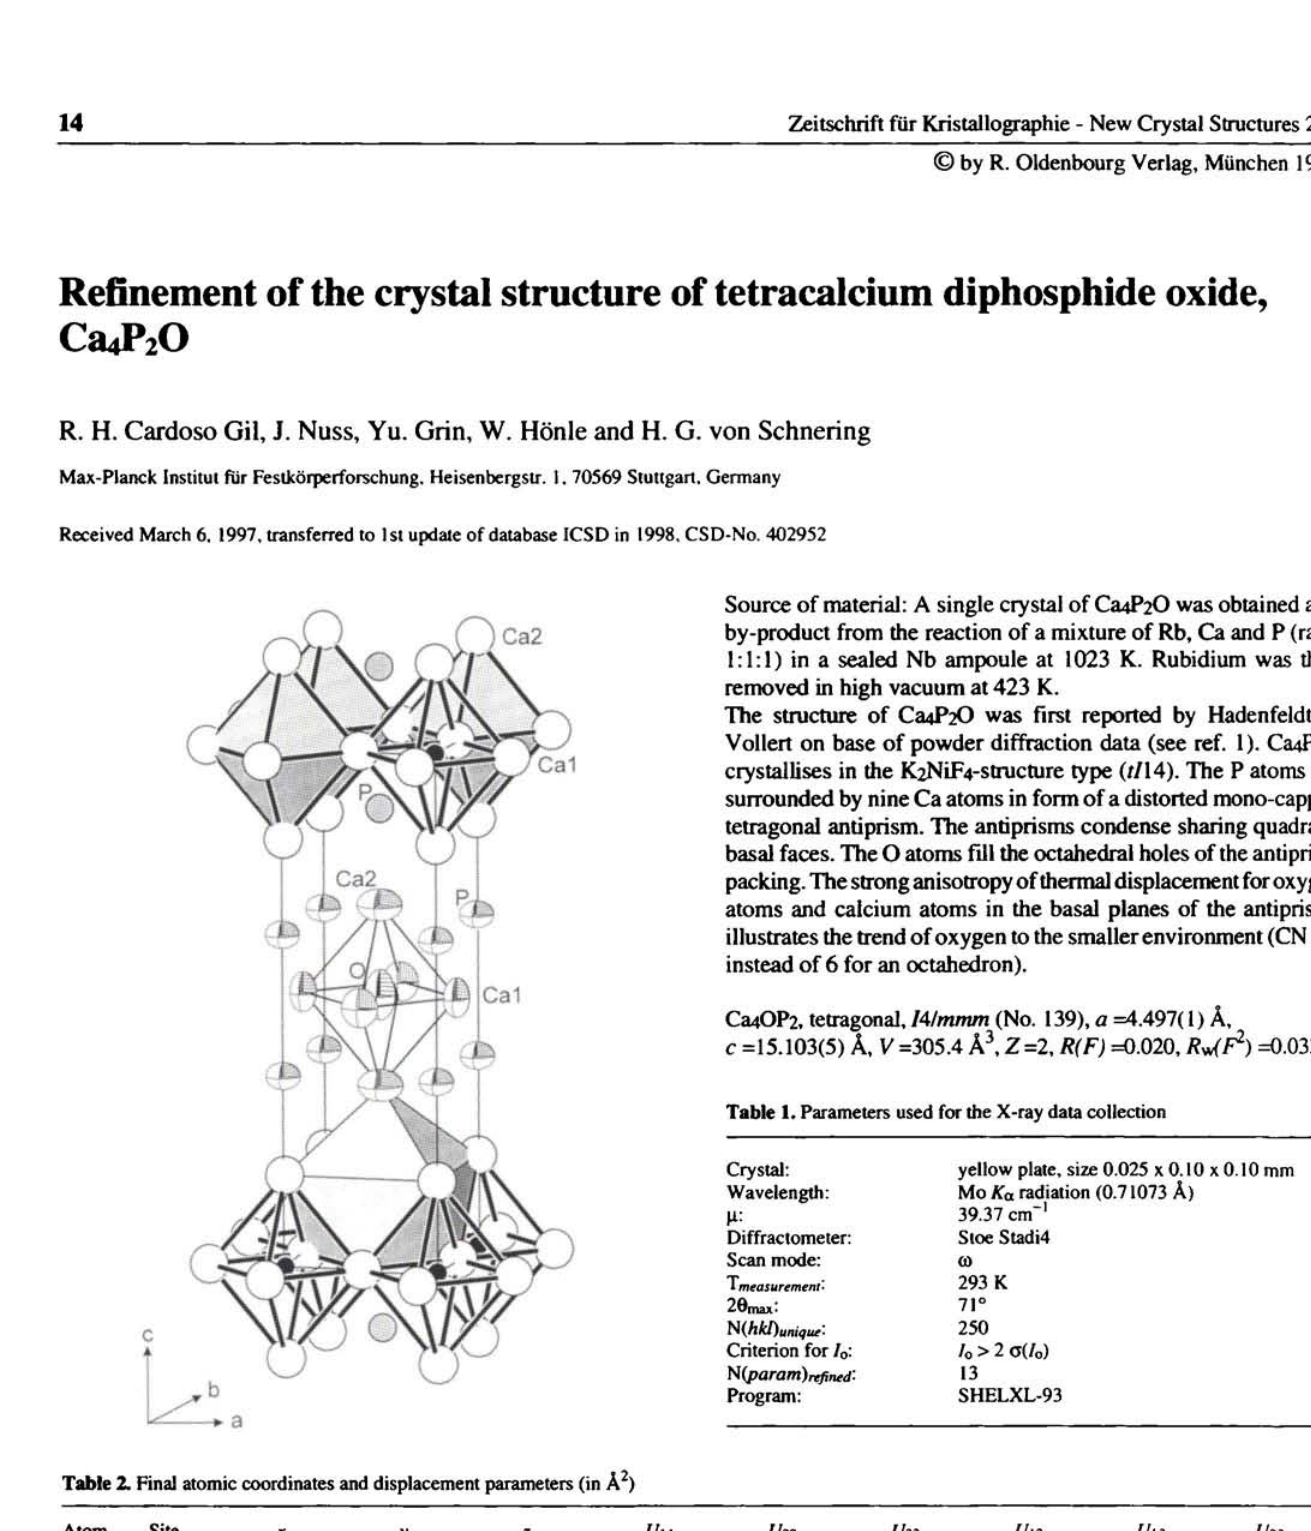
Table 2. Final atomic coordinates and displacement parameters (in Â^) Atom